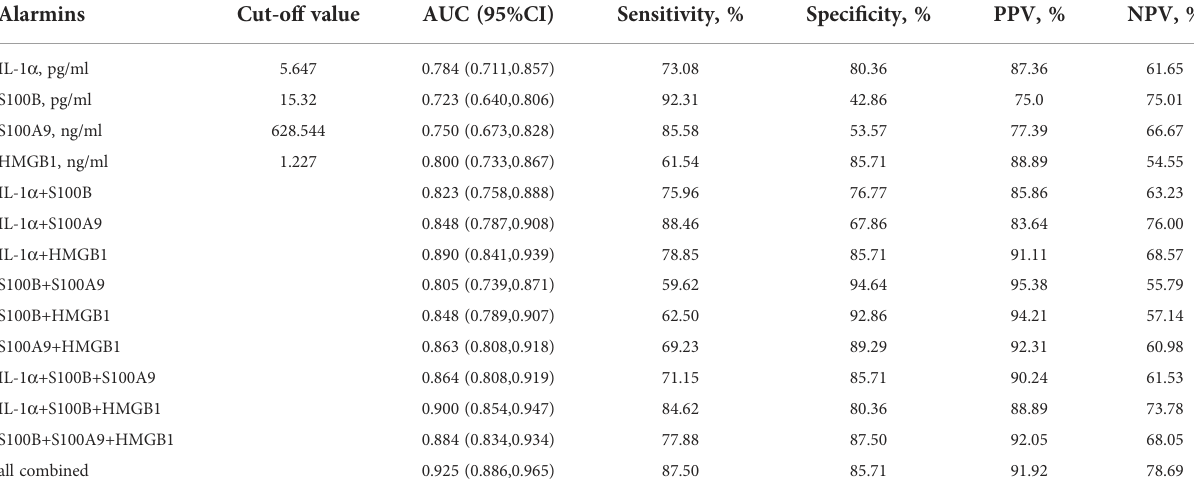
TABLE 2 Diagnostic values of biomarkers in patients with